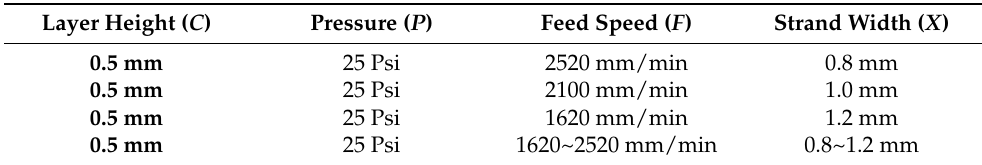
Table 2. The printing parameters of the dumbbell specimens. Layer Height ( C )